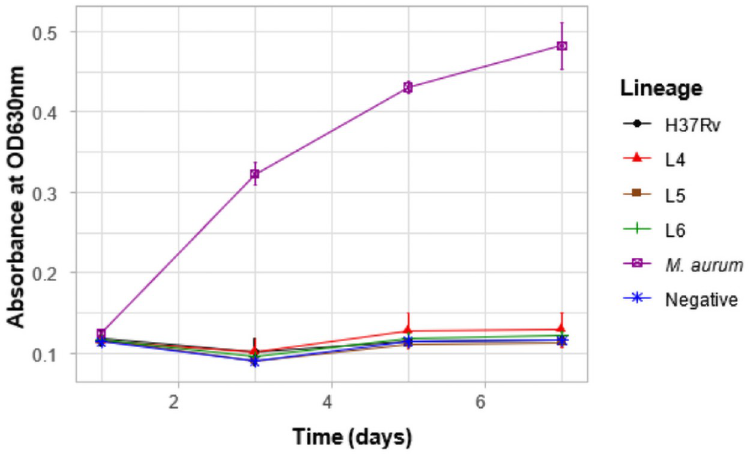
Fig 8. Tween hydrolysis test. A negative control depicted by the blue line had only the Tween hydrolysis reagent. Mycobacterium aurum represented by the purple line was included in the experimental set-up as a positive control.